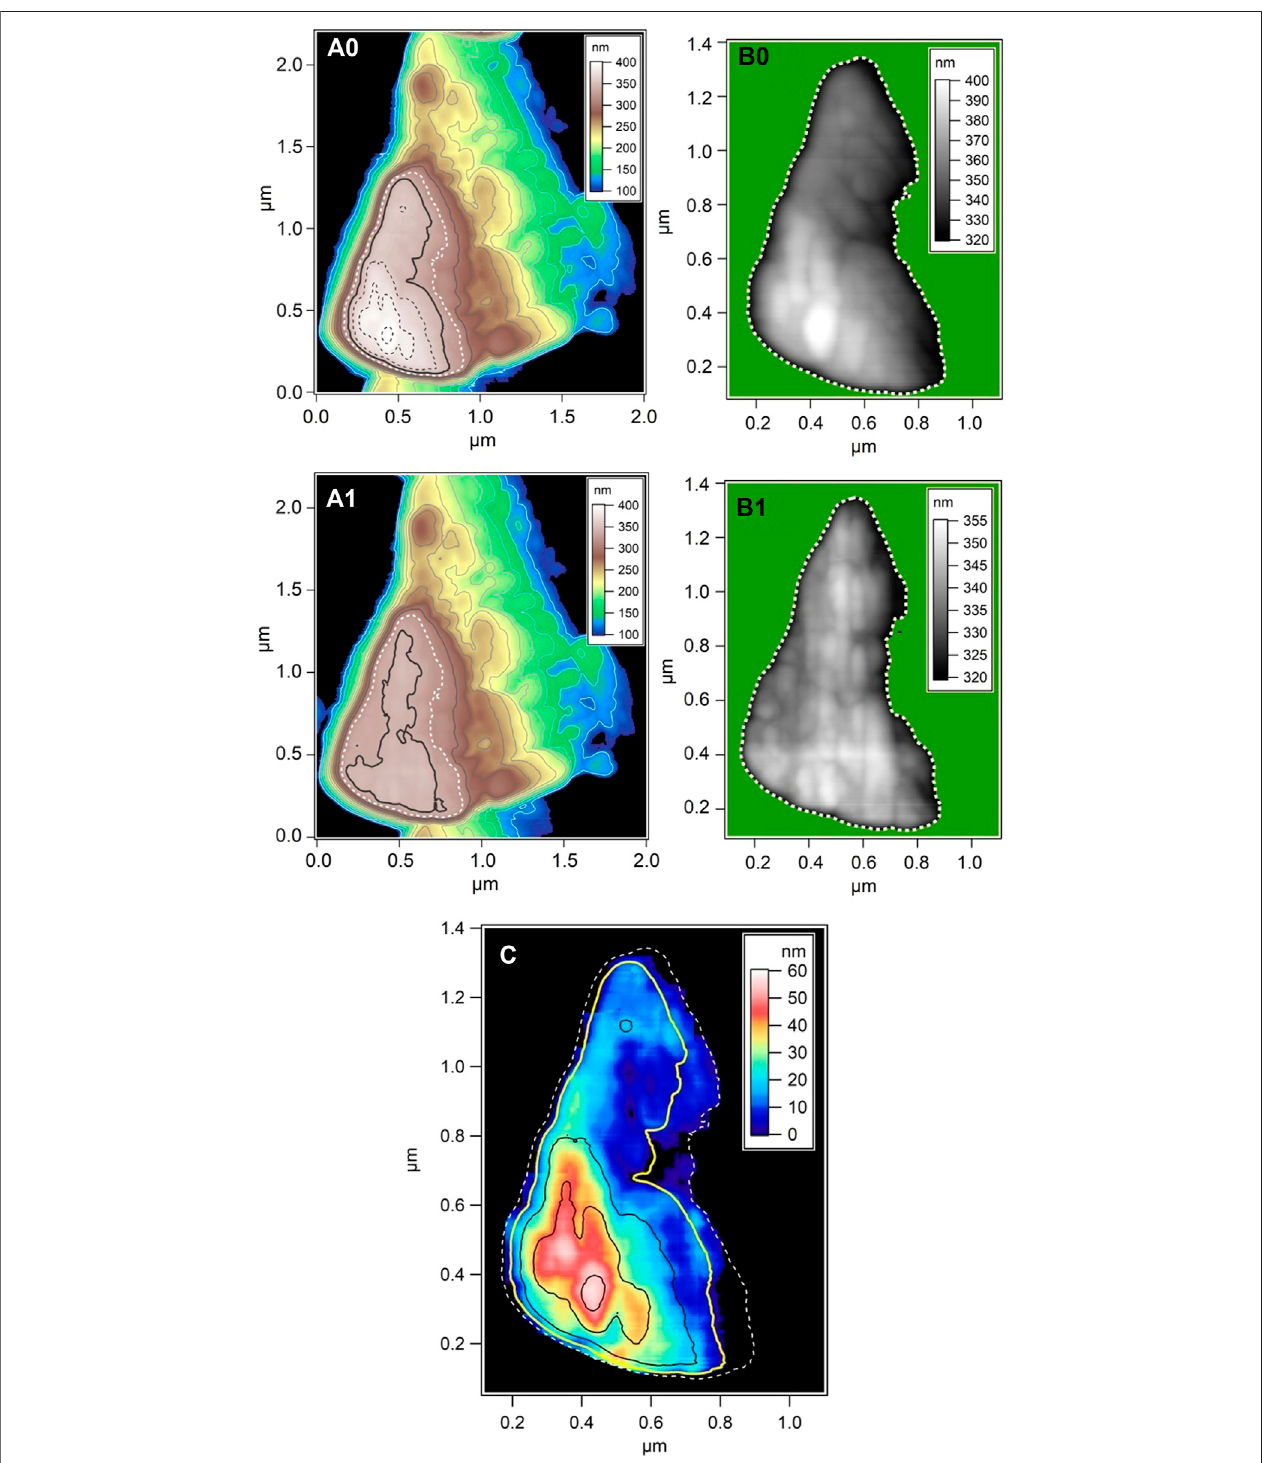
FIGURE15| Topographiesoftest particle No.3before (A0, B0) andafter atest (A1, B1) and heightsofthematerial worn duringthetest (C) .Panels (A0) and (A1) show the overall topographies and panels (B0) and (B1) the section of the surface that has changed in the test. The origin of all axes is the same, except the Z -axis in panel (C) .Contoursareshownasfollows:ascoloredlinesinpanels (A0) and (A1) every20 nmfrom100to300 nm,aswhitedashedlinesat320 nminallimages(being the highest unchanged one), as black dashed lines in (A0) or black continuous lines in (C) every 20 nm from 360 to 400 nm (being worn away in A1), and fi nally as black bold (A0, A1) or yellow lines (C) at 340 nm, being the contour that changed signi fi cantly.